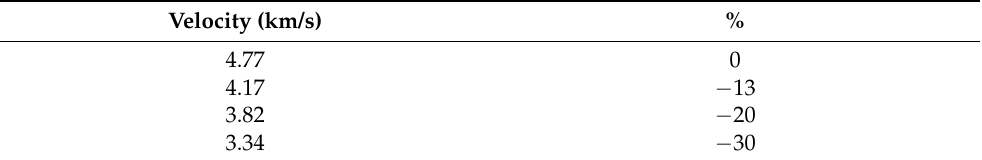
Table 2. The percentage of velocity